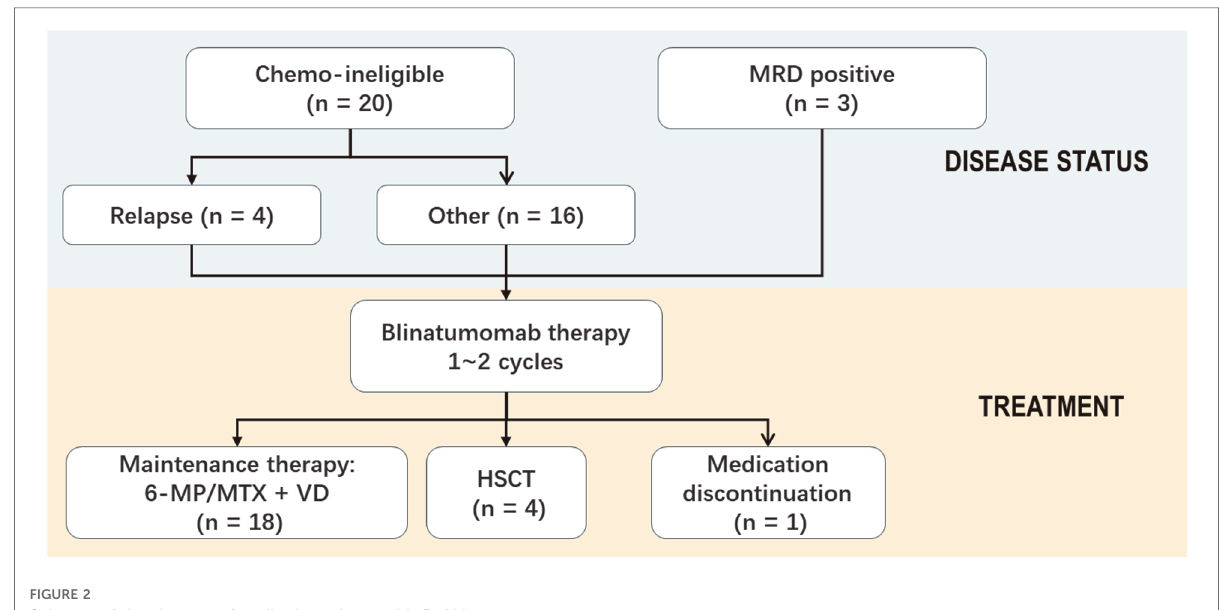
FIGURE 2 Schema of the therapy of pediatric patients with B-ALL.